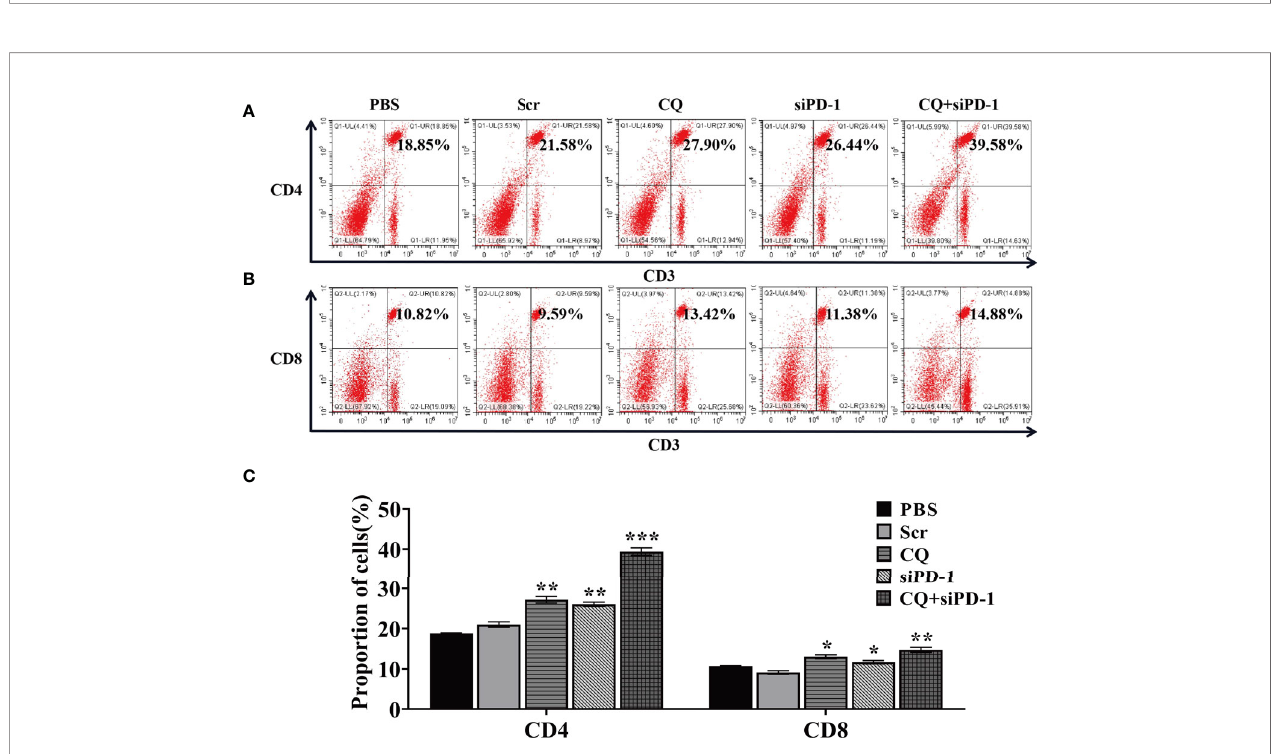
FIGURE 7 | The combination treatment of chloroquine and PD-1 siRNA can regulate the body ’ s anti-tumor immunity. (A, B) , Flow cytometry detects the proportion of CD4 + and CD8 + T cells in cells extracted from tumor tissue. (C) Data analysis of the ratio of cells positive for each surface marker. (* p < 0.05, ** p < 0.01, *** p < 0.001 vs PBS or Scr